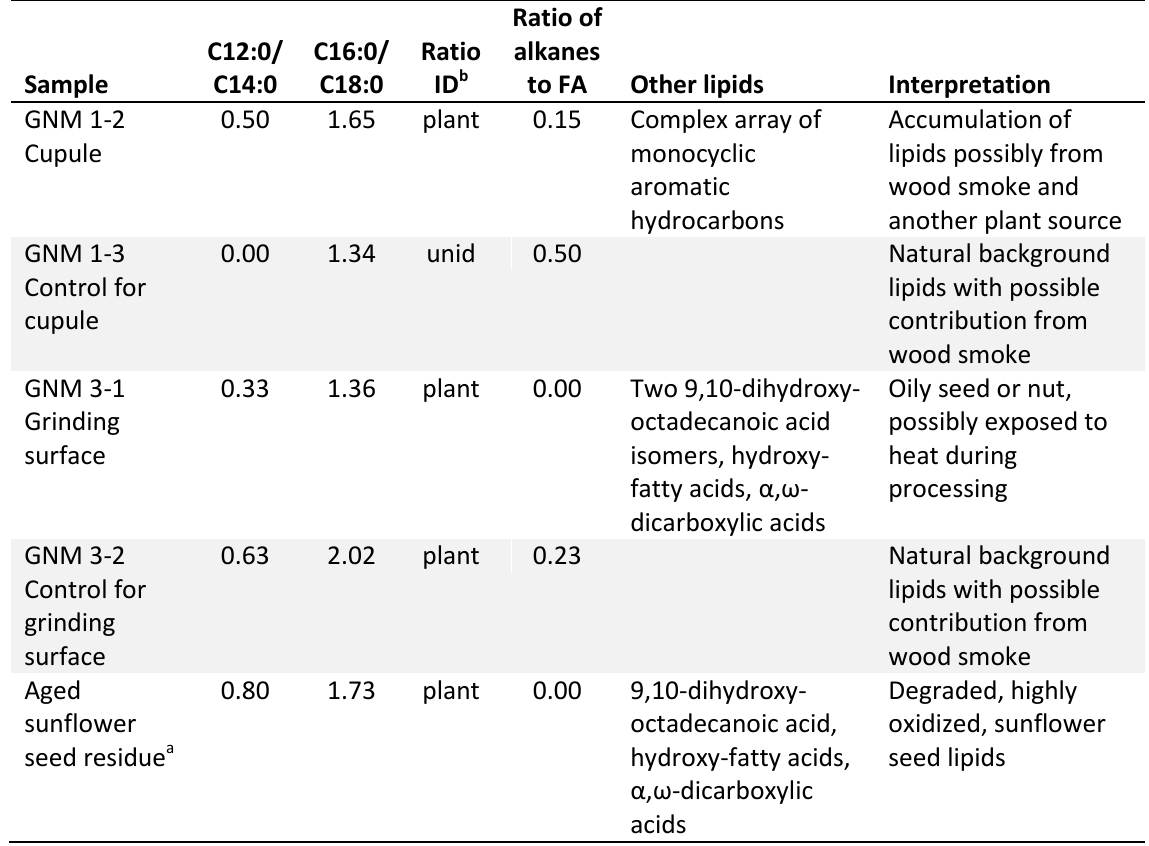
Table 2. Saturated fatty acid ratios and other lipids. Abbreviations: unid: